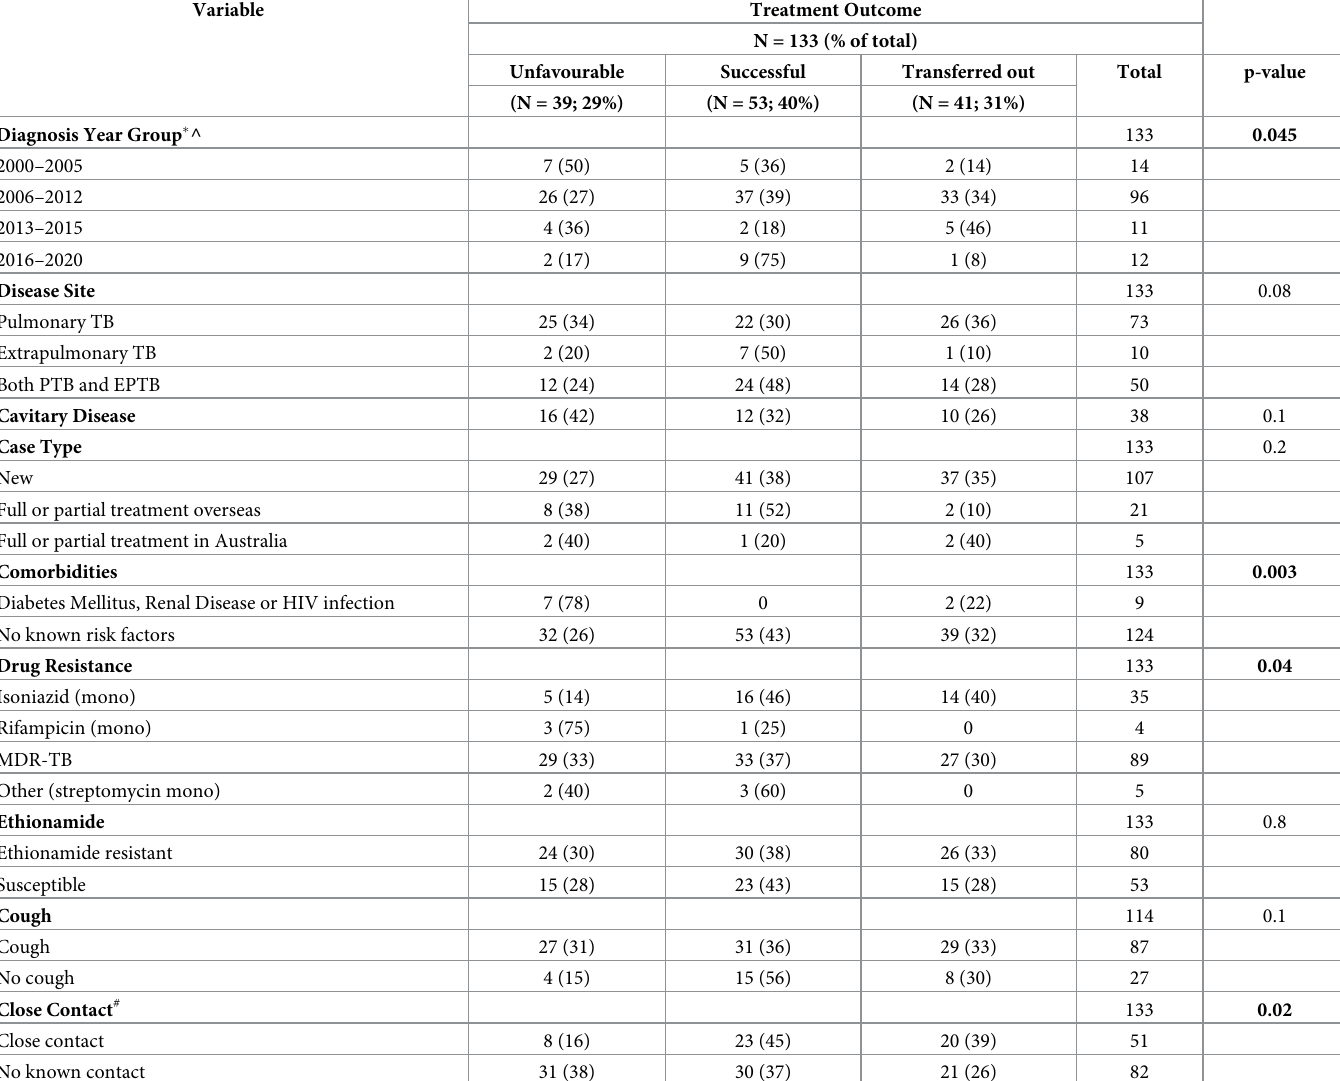
Table 2. Clinical variables of patients diagnosed with drug-resistant tuberculosis in the Torres Strait between 2000 and 2020, and their association with successful, unfavourable and other TB treatment outcome.